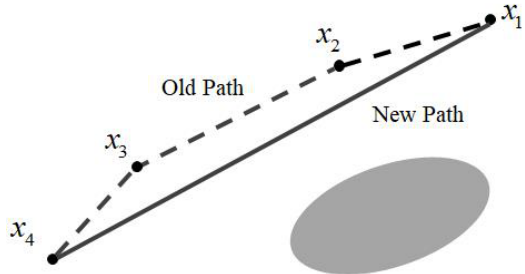
Figure 11. Geometric relation of optimal tree reconnection.